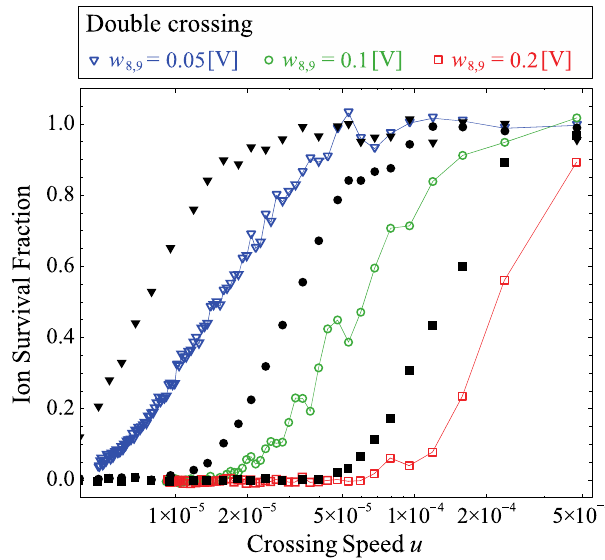
FIG. 10. Results of double resonance-crossing experiments. Two integer resonances at ν 0 ¼ 8 and 9 are consecutively crossed at various speed u . The amplitudes of the eighth and ninth dipole driving harmonics are set equal to 0.05 (triangle), 0.1 (circle), and 0.2 V (square). The rf phases of both sinusoidal waves are fixed at 0° at the beginning. The tune variation range is the same as that considered in the previous single resonance-crossing experiment in Fig. 8; namely, the initial tune is 9.5 eventually reduced to 7.5. For reference, the corresponding experimental data of single resonance crossing are plotted with black